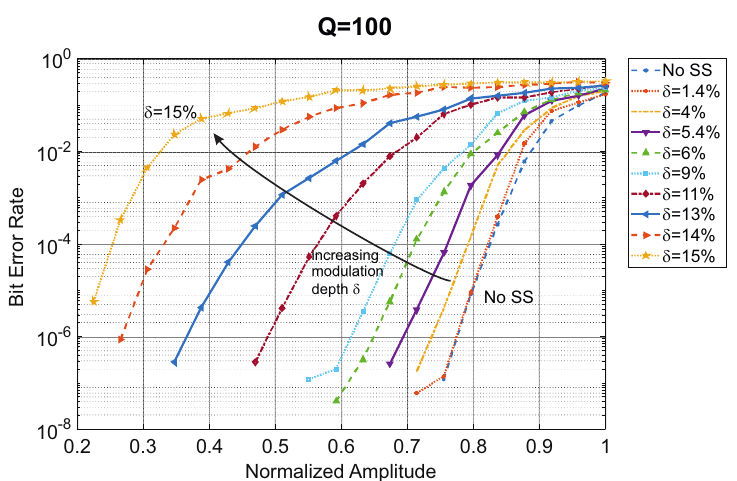
Figure 12. Bit error rate of a communication channel corrupted by SS-modulated EMI under strongly resonant coupling ( Q = 100) vs. EMI normalized r.m.s. amplitude at different modulation depth δ